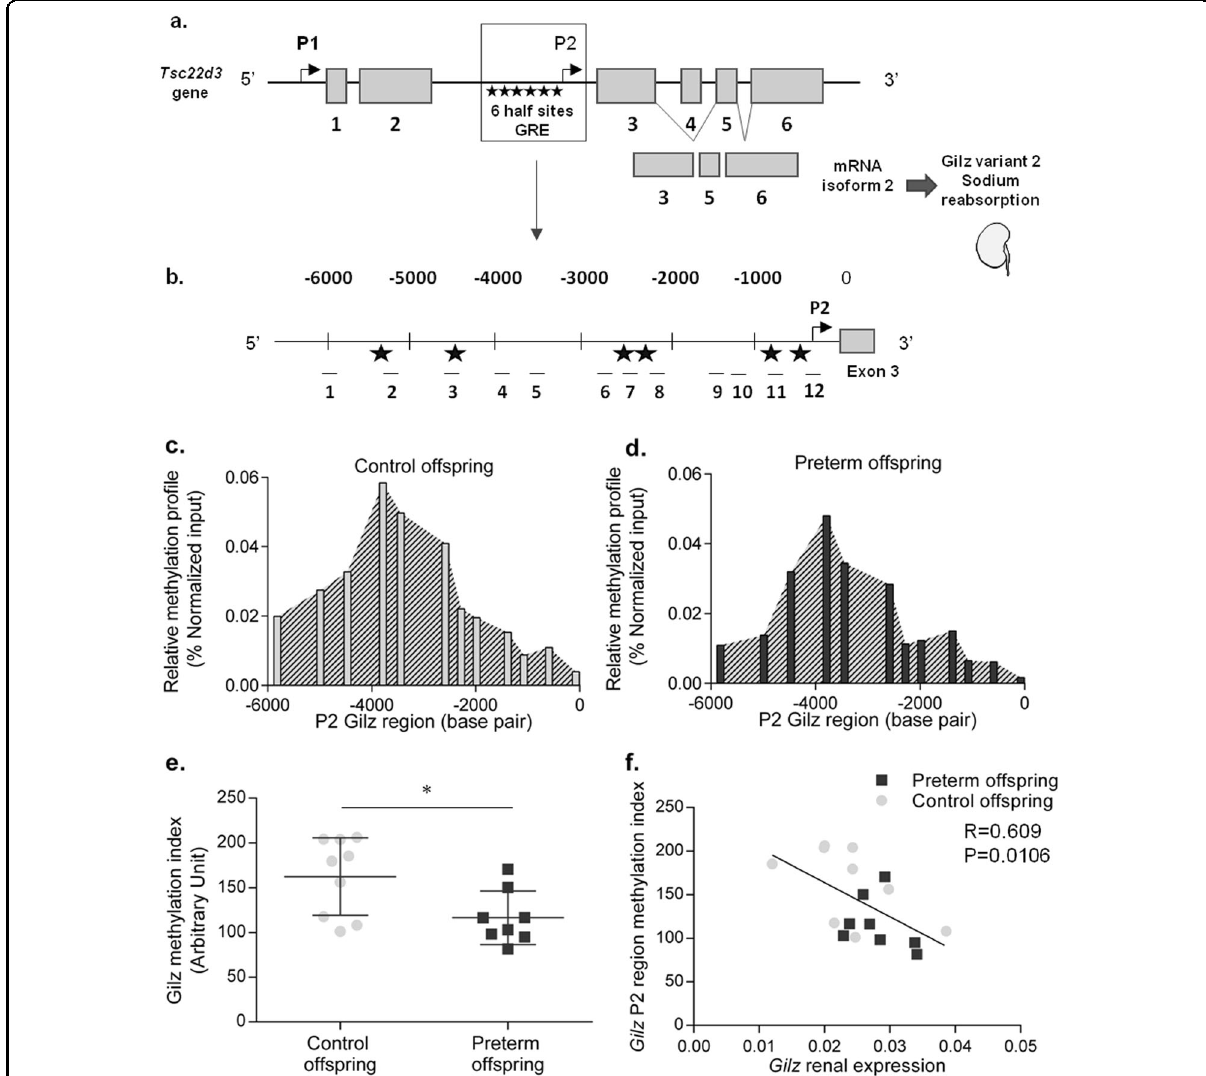
Fig. 2 Epigenetic regulation of the Gilz gene ( Tsc22d3) by DNA methylation in the second (F2) and third (F3) generations. Genomic structure of the Tsc22d3 mouse gene ( a ). Each gray box represents exons of the Tsc22D3 gene. Black arrows represent the 2 promoters regulating the transcription of the Gilz isoforms, named P1 and P2. The region upstream of P2 contains 6 half-site glucocorticoid responsive elements (GREs) represented by black stars. The alternative splicing of exon 3 allows the transcription of Gilz isoform 2, translated as protein variant 2, which is responsible for water and sodium reabsorption in the kidney. We focused on the region upstream of exon 3, regulating the transcription of Gilz ’ s isoform 2 ( b ). Zero has been arbitrarily de fi ned as the fi rst base of exon 3. The 6 GRE half-sites are represented as described above, as well as the 12 pairs of primers used to amplify the P2 region (see below). Relative methylation pro fi le of control ( c ) and preterm ( d ) male offspring at 6 months of age (M6). Methylation pro fi les were determined using ampli fi cation of methylated DNA with 12 pairs of primers in the region upstream of exon 3. Methylated DNA has been immunoprecipitated by a MeDIP technique; the results presented are the mean of the percent of methylated DNA compared to the input, normalized to the TSH2B -positive control gene for each primer pair, represented according to its position (in base pairs) in the P2 region. Gilz methylation index in control and preterm male offspring at M6 ( e ) in arbitrary units. The Gilz methylation index was determined by calculating the area under the curve (AUC) from the methylation pro fi les for each mouse. Each mouse in the control group is represented by a gray dot, and each mouse in the premature group is represented by a black square, with mean and SD for each group. Nonparametric Mann – Whitney U- tests. Correlations between the Gilz methylation index and Gilz renal mRNA expression in the F2 and the F3 generations ( f ) were obtained by Spearman regression analysis. MeDIP was performed by pooling samples from the F2 and F3 generations (after ensuring that the results were consistent in both generations), with n = 8 in the preterm group and n = 9 in the control group. * P < 0.05, ** P < 0.01, *** P <